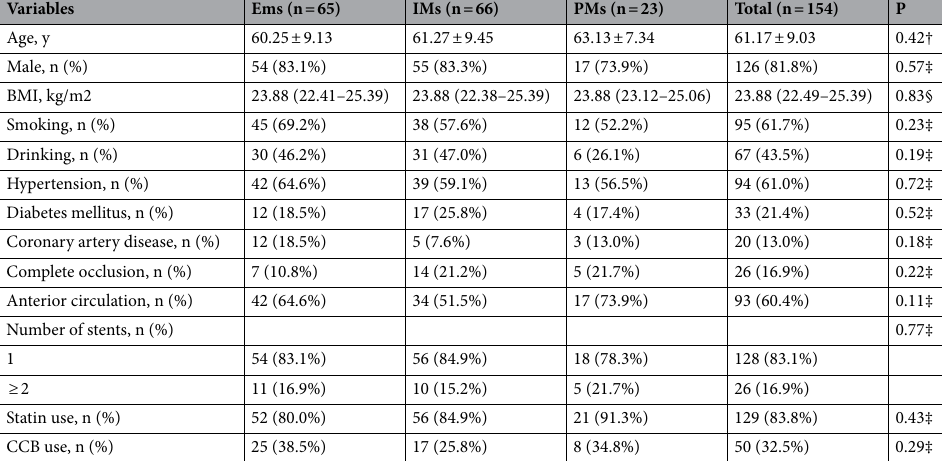
Table 2. Baseline characteristics of patients who had undergone stenting procedure for cerebral artery stenosis. † P-value from one-way ANOVA test; ‡ P-value from χ 2 test; § P-value from Kruskal–Wallis test; BMI, body mass index; CCB, calcium channel